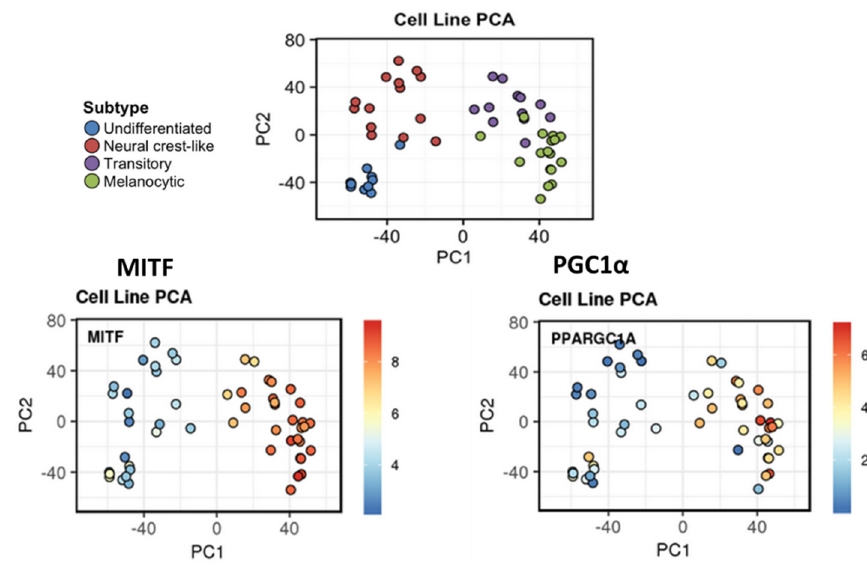
Figure 6. MITF-PGC1 α axis in melanoma plasticity. High correlation between MITF and PGC1 α expression across melanoma phenotypes in the panel of 53 human melanoma lines used in Tsoi et al. 2018 [25]. PCA of melanoma cell line expression profiles are annotated by identified clusters. MITF and PGC1 α are highly expressed in the melanocytic (C4-green) and the transitory (C3-purple) phenotypes whereas this expression is low in the invasive phenotypes (neural crest-like (red) and undifferentiated (blue) phenotypes). Illustration was created by using the interactive web interface resource [25] available at http://systems.crump.ucla.edu/dediff/.